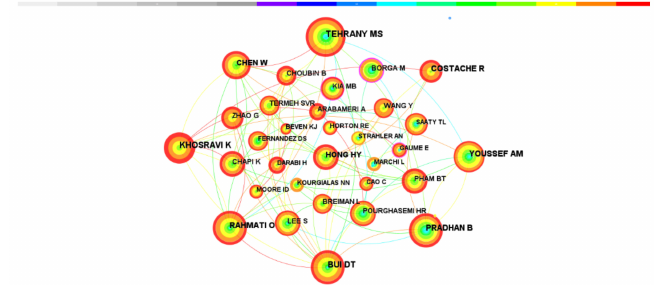
Figure 9. Author co-citation